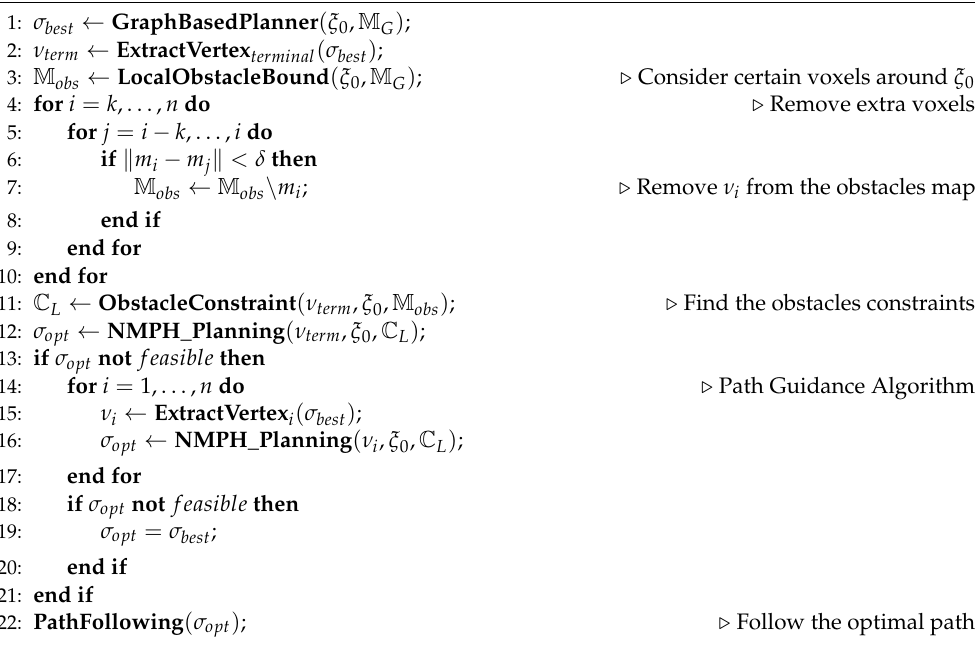
Algorithm 3 Local Optimal Path Planning using